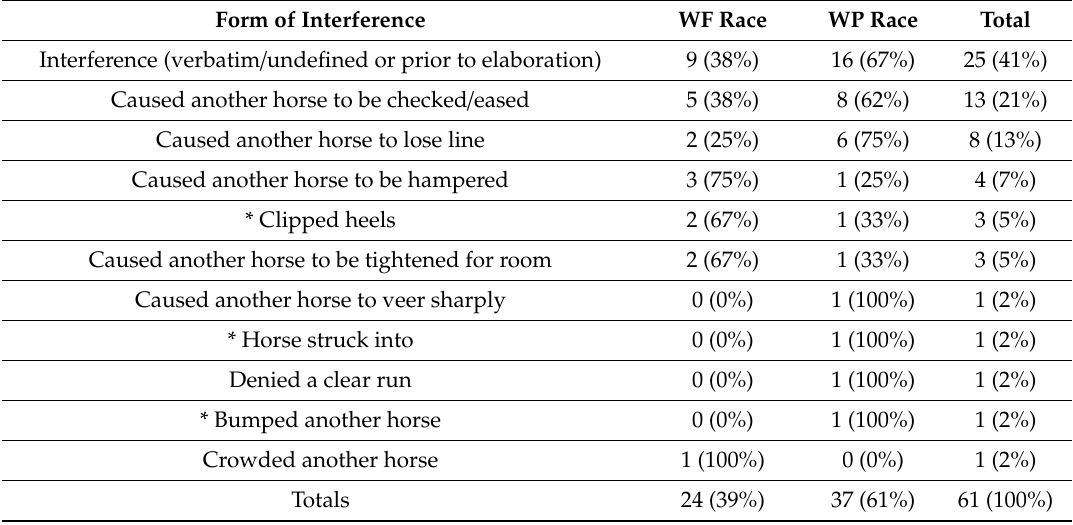
Table 3. The 61 instances of interference as described in the stewards’ reports. The asterisk (*) denotes undeniable physical contact between